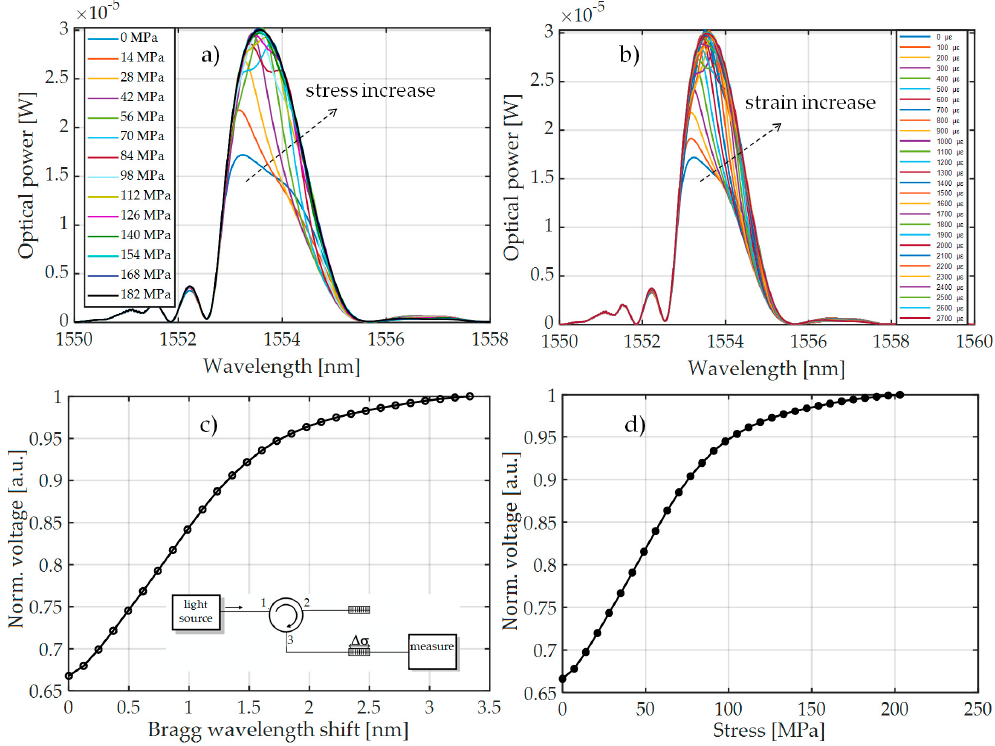
Figure 7. The measurement results obtained from the interrogation stand (as in Figure 3a) for the matched grating pair FBG + FBG1: ( a ) Spectral response change for an increase of tension; ( b ) spectral response change to an increase of strain; ( c ) the transient characteristic of wavelength shift to direct current (DC) voltage generated by the photodetector; ( d ) characteristics of power line wire tension conversion to a change of photodetector voltage.